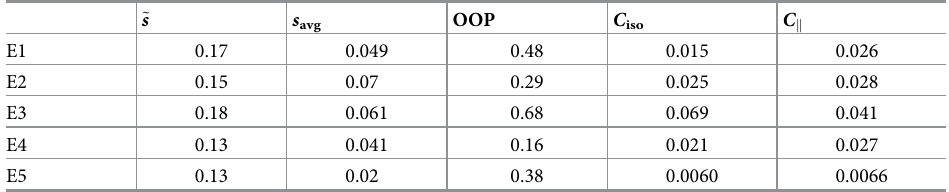
Table 3. Sarc-Graph computed ~ s , s avg , OOP, C iso , and C k for each experimental data